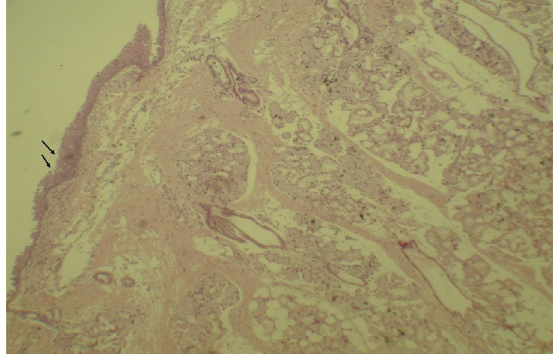
Mucosa of the maxillary sinus showing areas of ero- sion in the epithelium (arrows) and inflammatory cells. Optical microscopy, HE staining, 100 ×